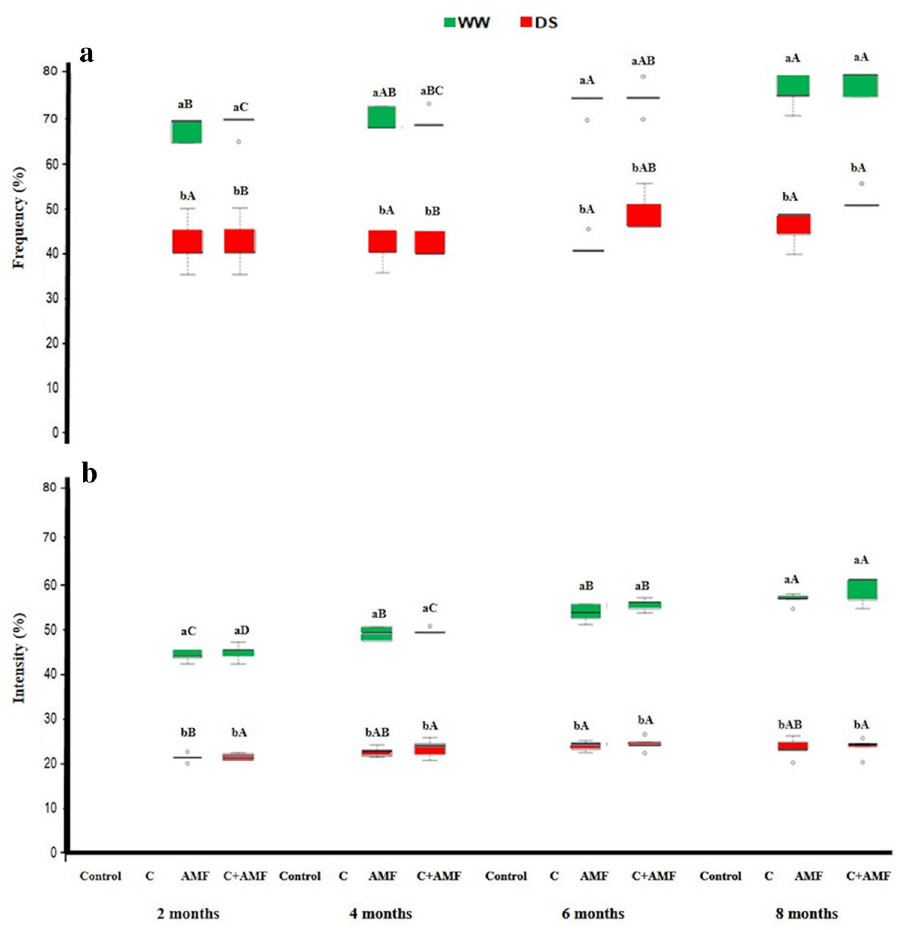
Figure 1. Effects of water regimes (WW: well-watered; open bars and DS: drought stress; filled bars) on (a) AMF infection frequency and ( b ) intensity in control carob plants and plants amended with compost (C) and/or assemblage of indigenous arbuscular mycorrhizal fungi (AMF). Data are mean ± SE (n = 5). Means followed by the same letters within the same time point are not significantly different at P < 0.05 (Tukey’s HSD). The